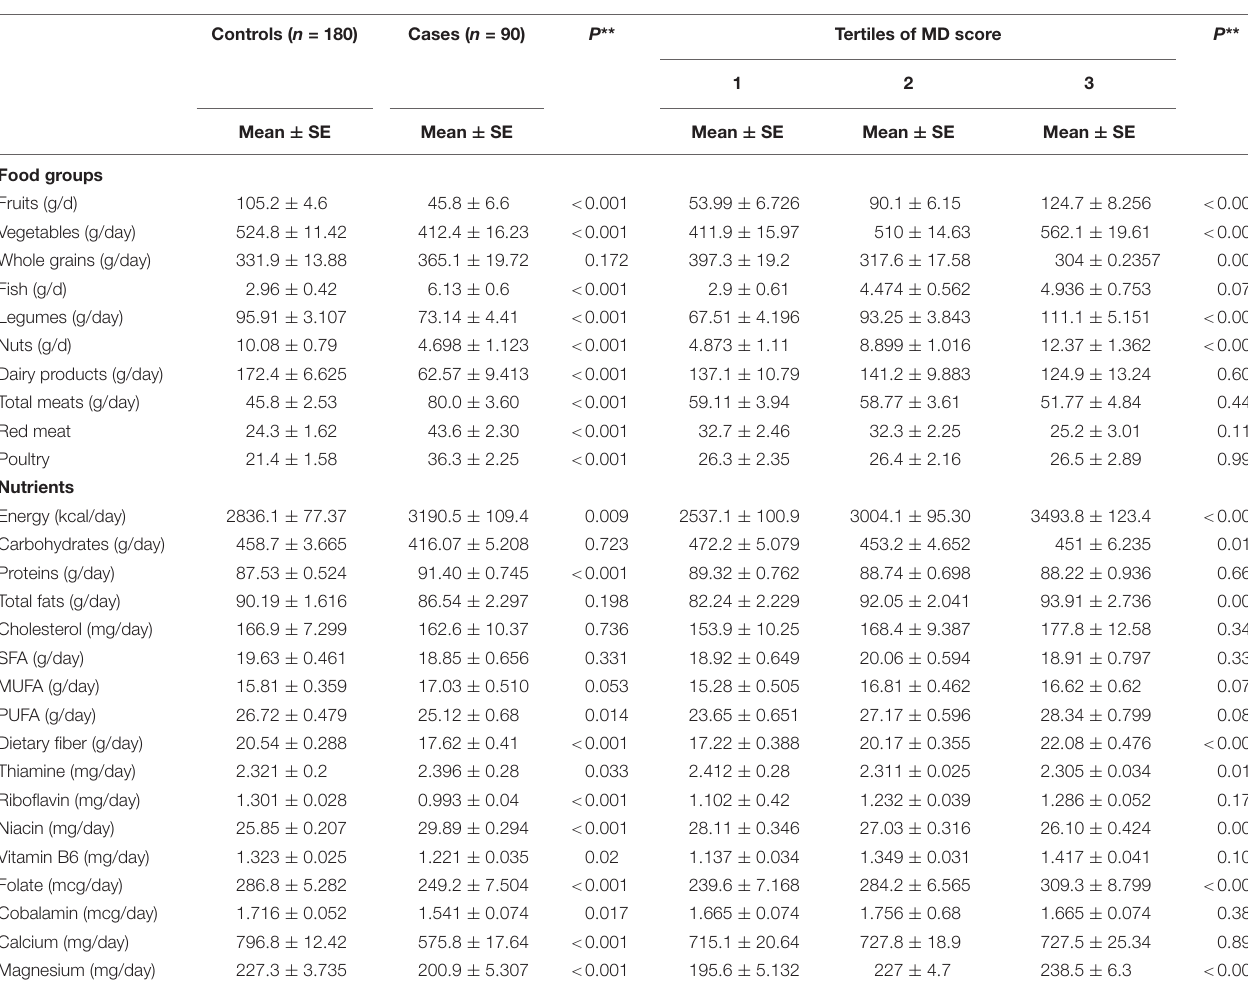
TABLE 2 | Food and nutrients intakes of study